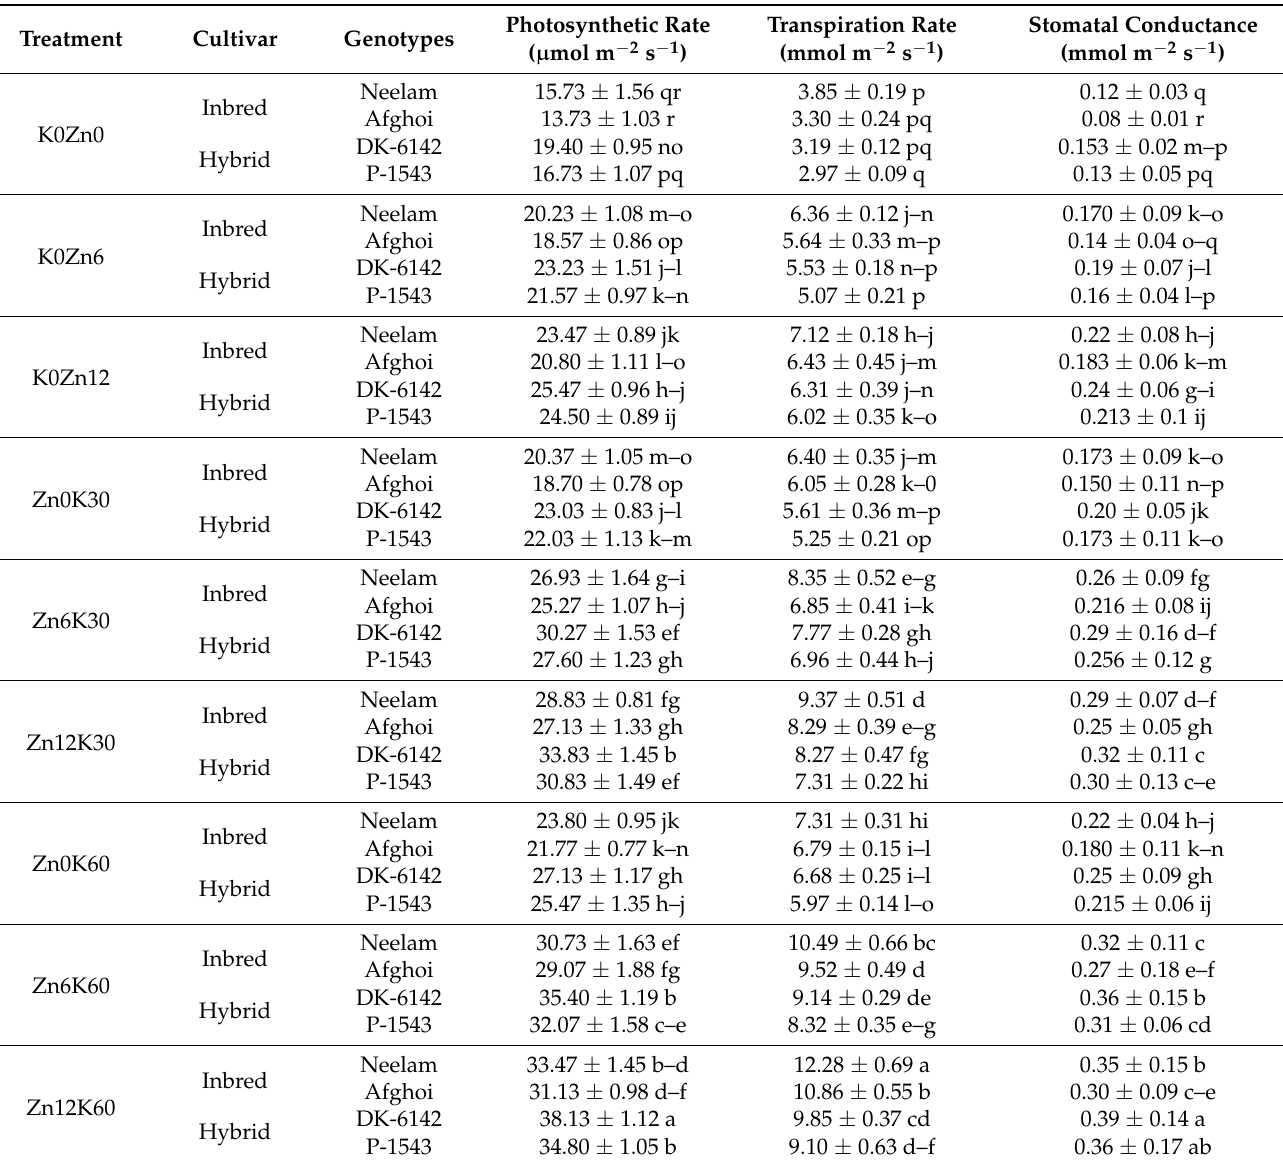
Note: All values are given as means ± standard deviations. The lettering indicates the significance difference with reference to LSD test